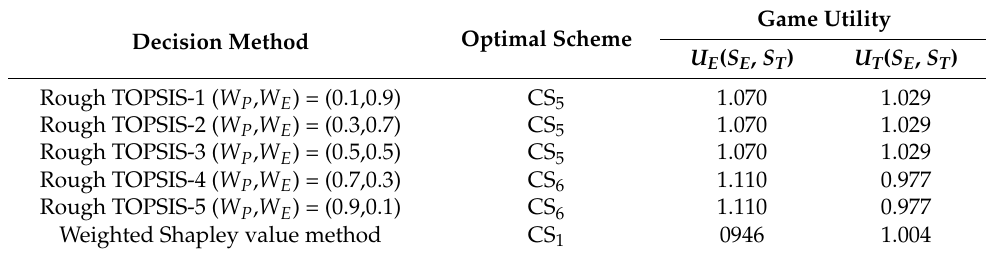
Table 13. The optimal scheme for two decision